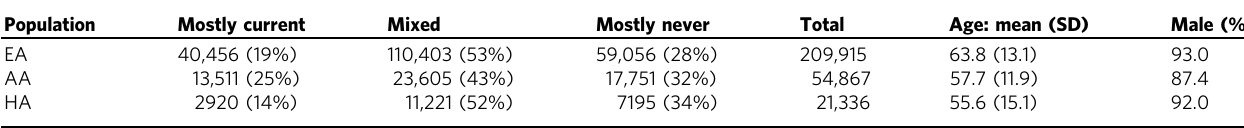
Table 1 Phenotype distribution of smoking trajectories and demographic characteristics in the Million Veteran Program ( N = 286,118).